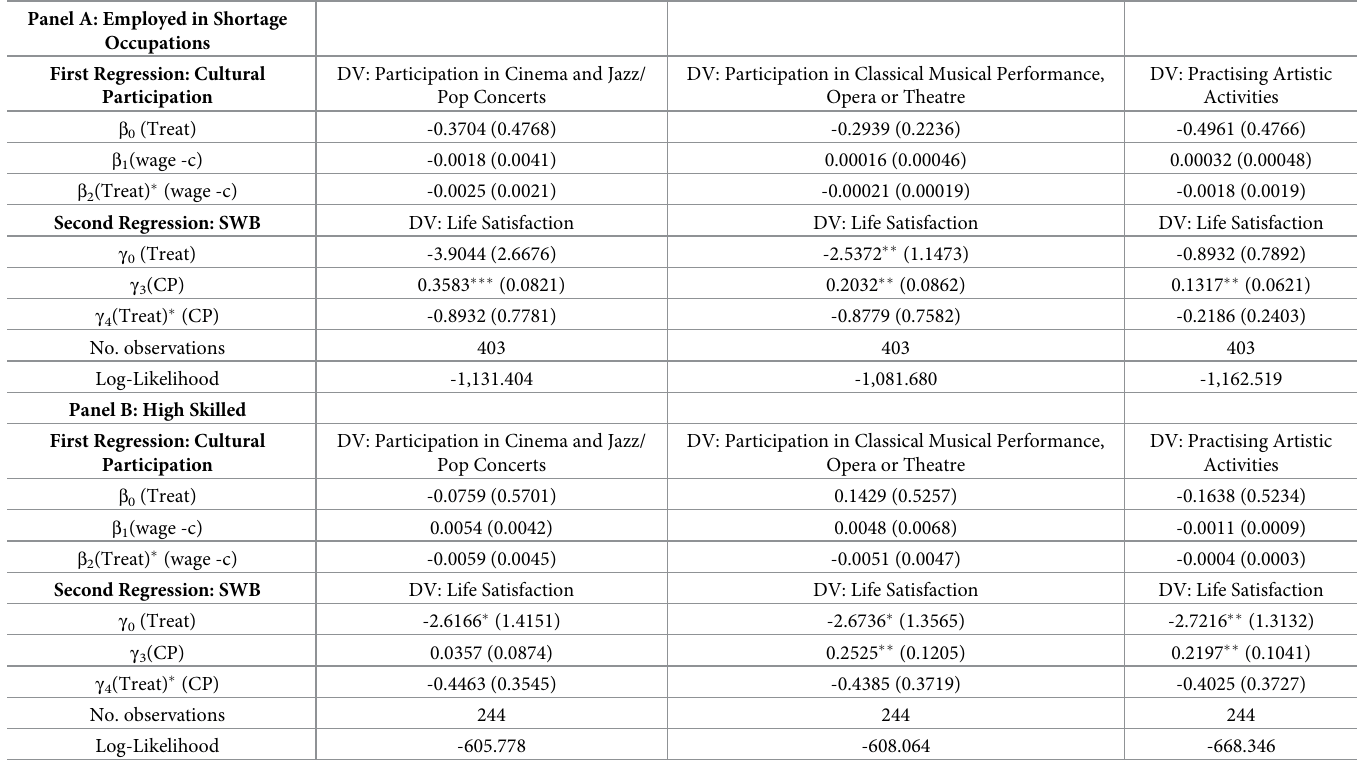
Table 11. Robust check: Sharp RDD estimates using as policy reform the year 2011, with uniform Kernel and bandwidth 4,000 €